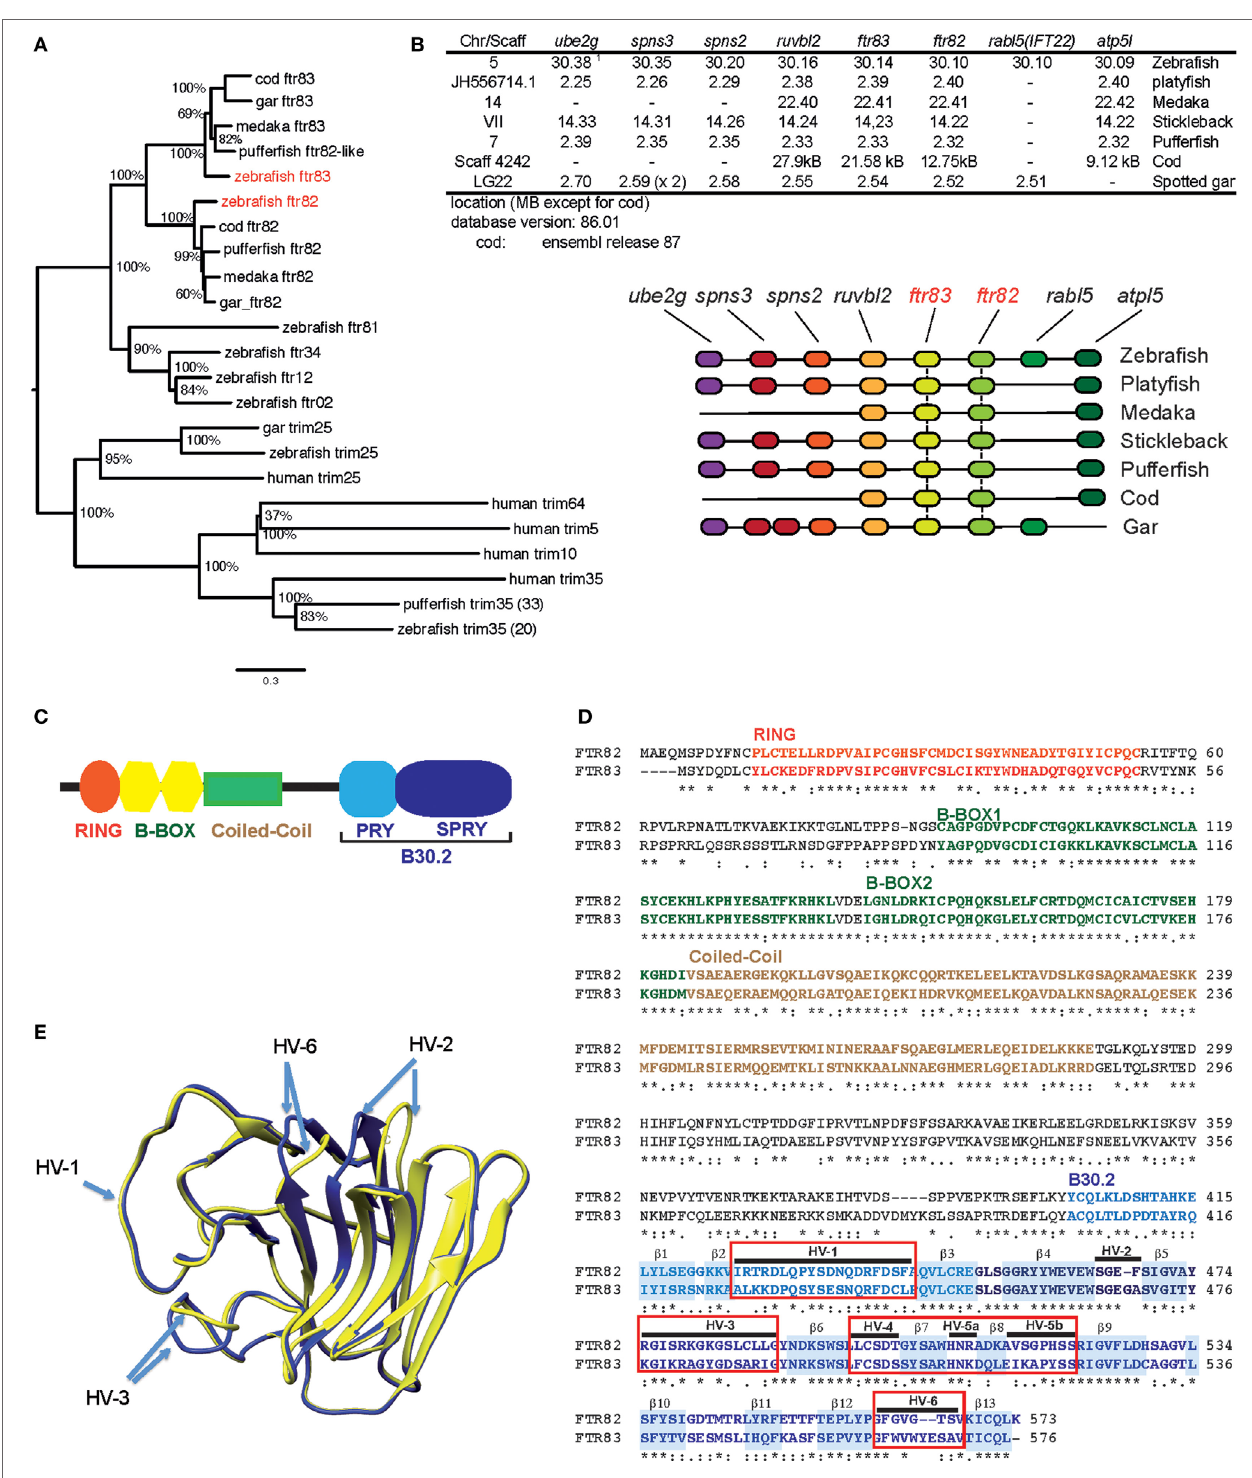
FigUre 1 | ftr82 and ftr83 , two members of the fintrim family conserved across teleost fish . (a) Neighbor joining tree including zebrafish ftr82 and ftr83 , and their orthologs in several fish species, other fintrims, and the most similar homologs of finTRIM in fish and in human. (B) Comparison of the conserved genomic context of ftr82 and ftr83 genes in different fish species, as shown using the Genomicus software, with their genomic location. (c) Typical domain structure of finTRIMs. (D) Alignment of FTR82 and FTR83 sequences with hyper variable loops of the B30.2 domain highlighted. (e) Molecular modeling of B30.2 domains from FTR82 (yellow) and FTR83 (blue) derived from homology modeling based on crystal structure of huTRIM25 B30.2 domain. Visualization of models superposition was performed with the program